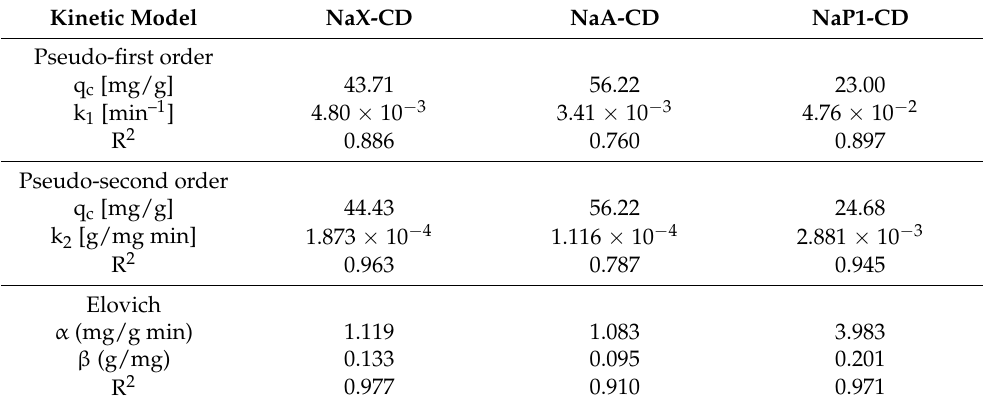
Table 5. Kinetics parameters for the adsorption of tetracycline on NaX-CD, NaA-CD and